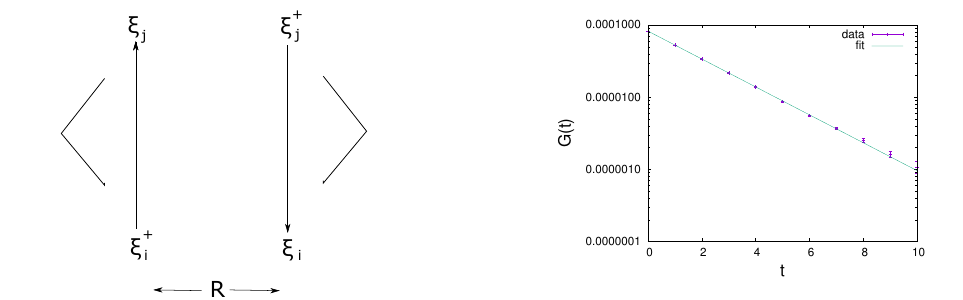
Figure 4. Determination of the photon mass at β = 10 . 9 ,γ = 0 . 6 from the time correlator G ( t ) of space averaged gauge invariant link variables A i on a 16 3 × 36 lattice volume. The straight line on the log plot is a best fit of ae − m ph t to the data, where m ph is the photon mass, and a is a constant.